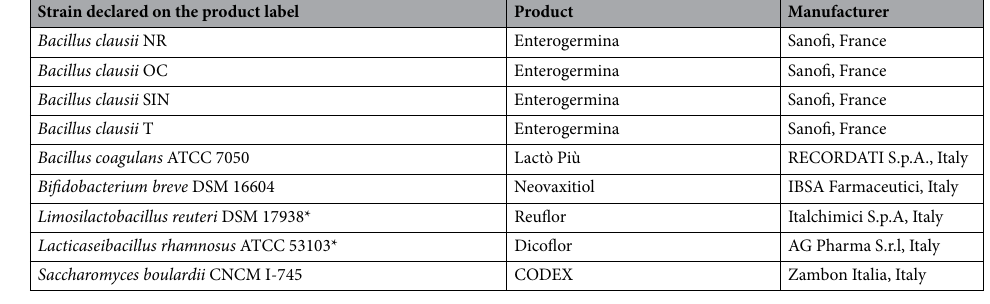
Table 2. Probiotic strains used in this study and commercial formulations from which they were isolated. *The nomenclature of these strains, originally reported as Lactobacillus reuteri DSM 17938 and Lactobacillus rhamnosus ATCC 53103 on the product labels, was updated according to the current nomenclature 69